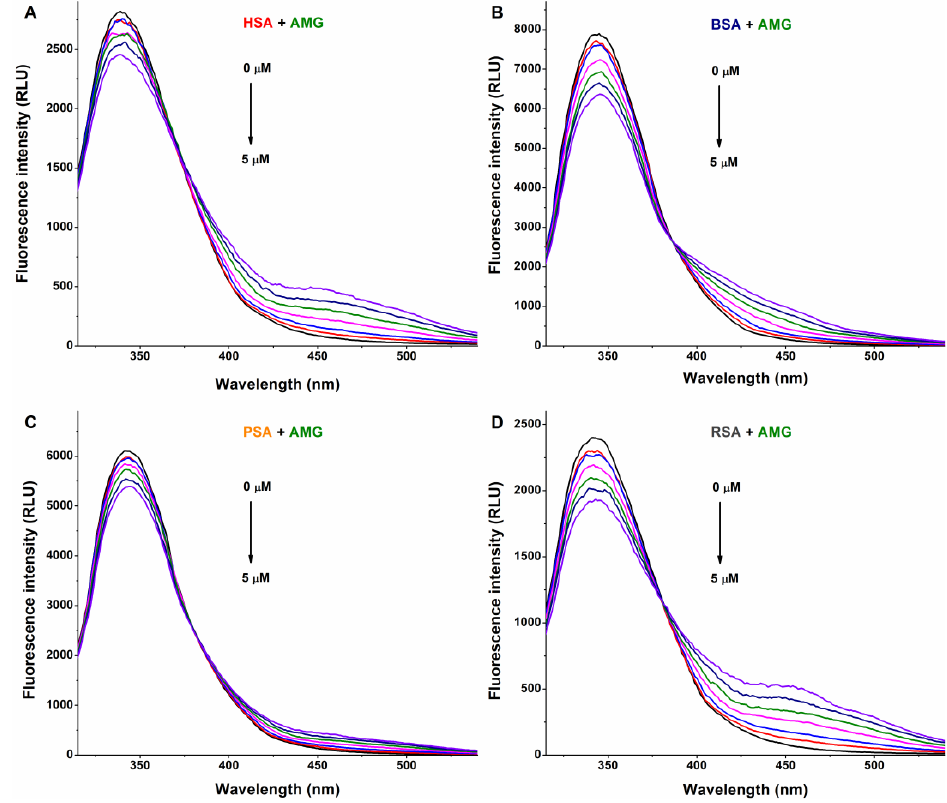
Figure 3. Representative fluorescence emission spectra of albumins, and the quenching effects of alternariol-9-monomethylether-3-glucoside (AMG): Impacts of AMG (0–5 µ M) on the emission signals of human (HSA; ( A )), bovine (BSA; ( B )), porcine (PSA; ( C )), and rat (RSA; ( D )) serum albumins in PBS (pH 7.4; albumin concentration: 2 µ M; λ ex = 295 nm).